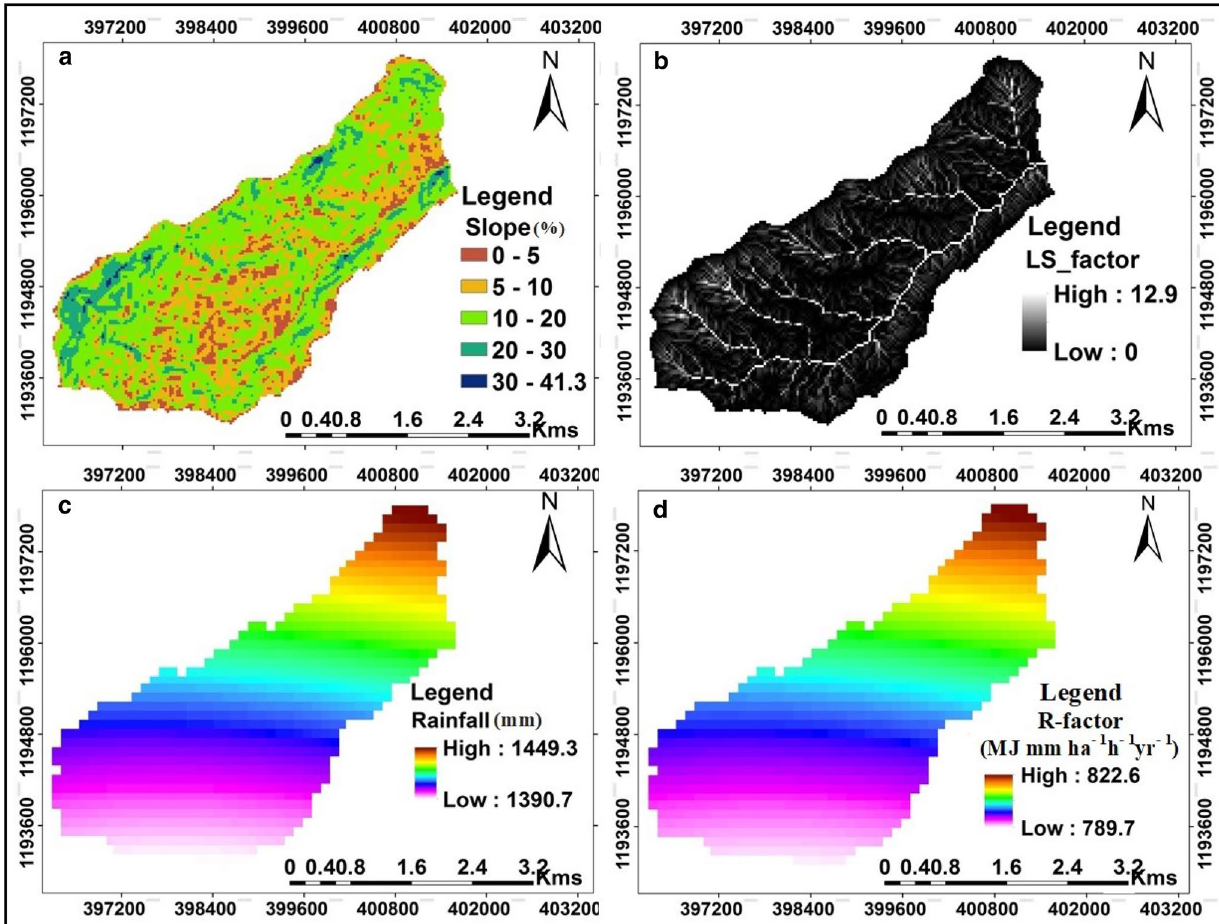
Fig. 3 Slope ( a ), LS ( b ), rainfall distribution ( c ), and R-factor ( d ) maps of the